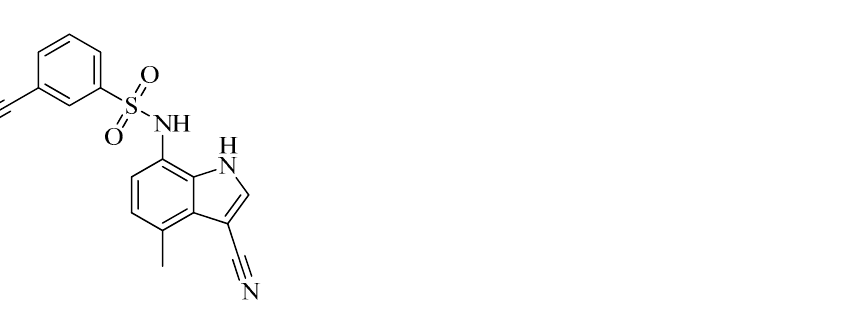
Figure 6. Chemical structure of the heterocyclic sulfonamide anti-angiogenic